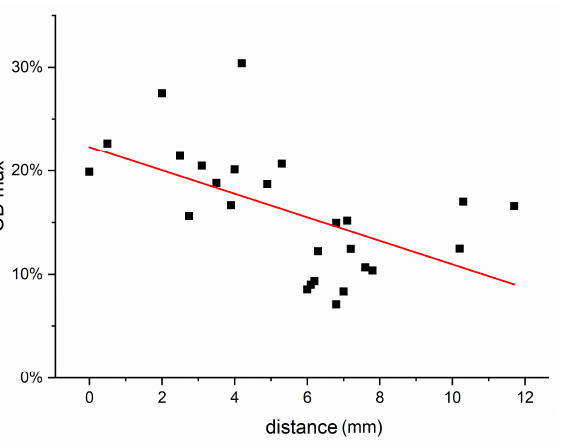
Figure 8. Graphic presentation of the maximum mean optical densities of all ipsilateral and contralateral examined brain areas with the distance (mm) to the treated CPu. A mean negative linear correlation (Pearson correlation coefficient = − 0.55; p = 0.0039) was found between the distance to the BoNT-A-treated CPu and the maximum values of the interpolated curves for OD. The red line is the regression line calculated from the compared values.